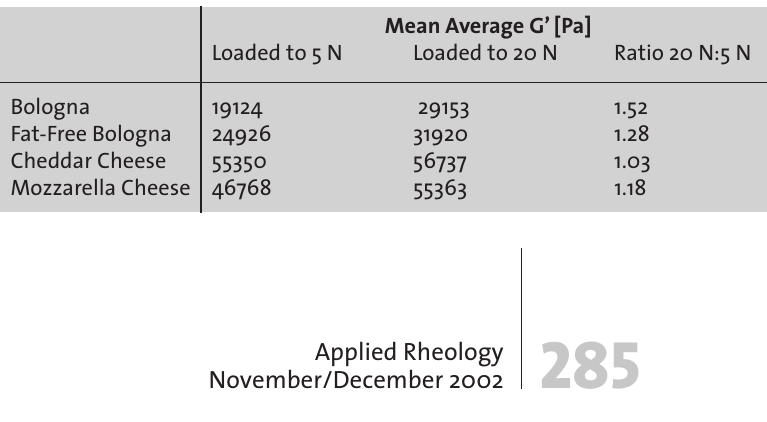
Table 1 (below): Mean average G’ values* of semi-solid samples loaded to 5 and 20 N (stress sweep at 10 Hz; *mean G’ values are each the average of 24 different